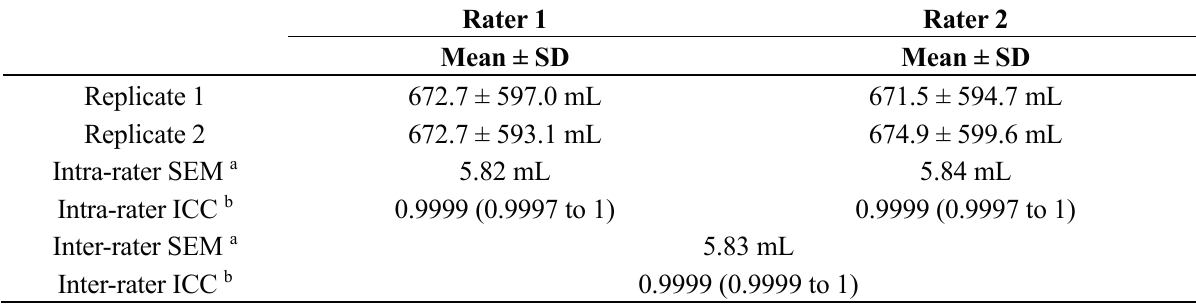
Table 3. Reliability of SkanLab in measuring inanimate objects (cylinders; N = 12).